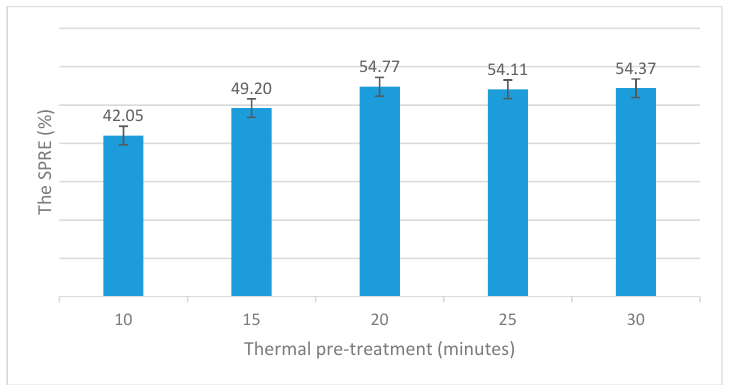
Figure 7. The effect of thermal pre-treatment duration on the SPRE. Figure 7. The e ff ect of thermal pre-treatment duration on the